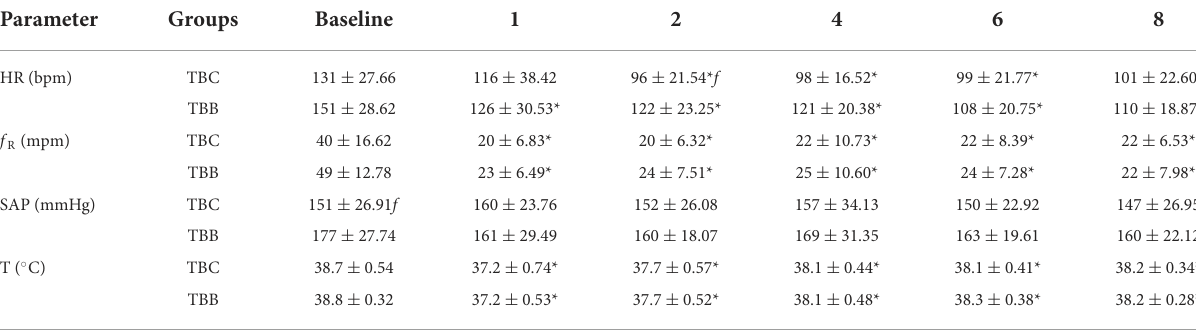
TABLE 2 Mean ± standard deviation referring to heart rate, respiratory rate, systolic blood pressure and rectal temperature in the post-operative period of the 32 animals in the two study groups during the evaluated times. Parameter